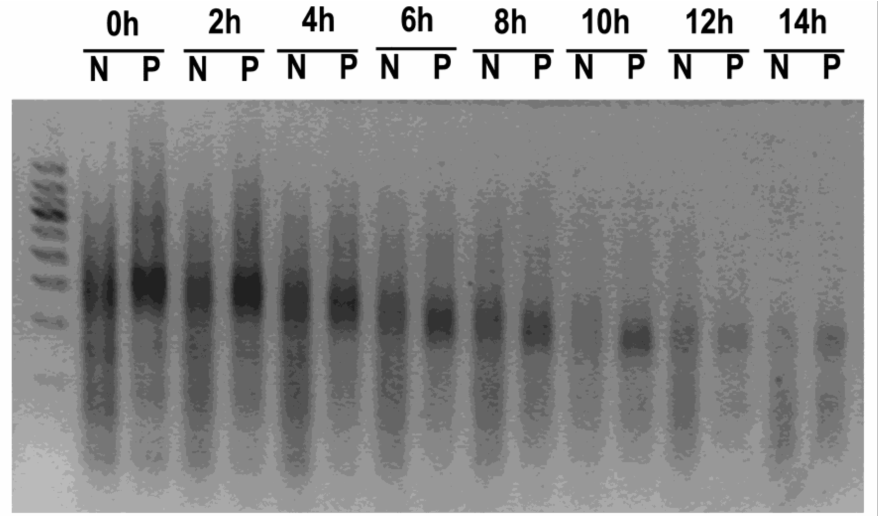
Figure 4. Electrophoresis of Apt-HJ after incubation in 50% serum for various time periods. (N: